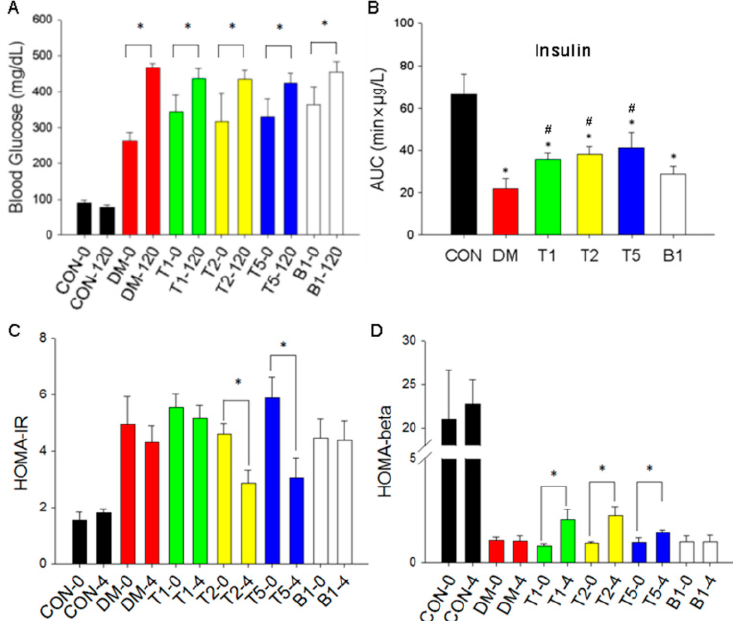
Figure 4. Effect of guava juice and trehalose on OGTT ( A ); insulin levels ( B ); HOMA IR ( C ) and HOMA- β ( D ) in six groups of rats at week 0 and week 4. Data are expressed as mean ± SEM and analyzed by two-way ANOVA. n = 3–5 in each group. * p < 0.05 vs. the value at week 0 of respective group. # p < 0.05 vs. DM.